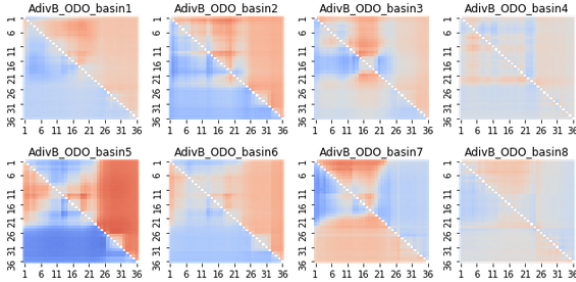
Figure 10. A/B-correlations for the parameter ODO classified by basins